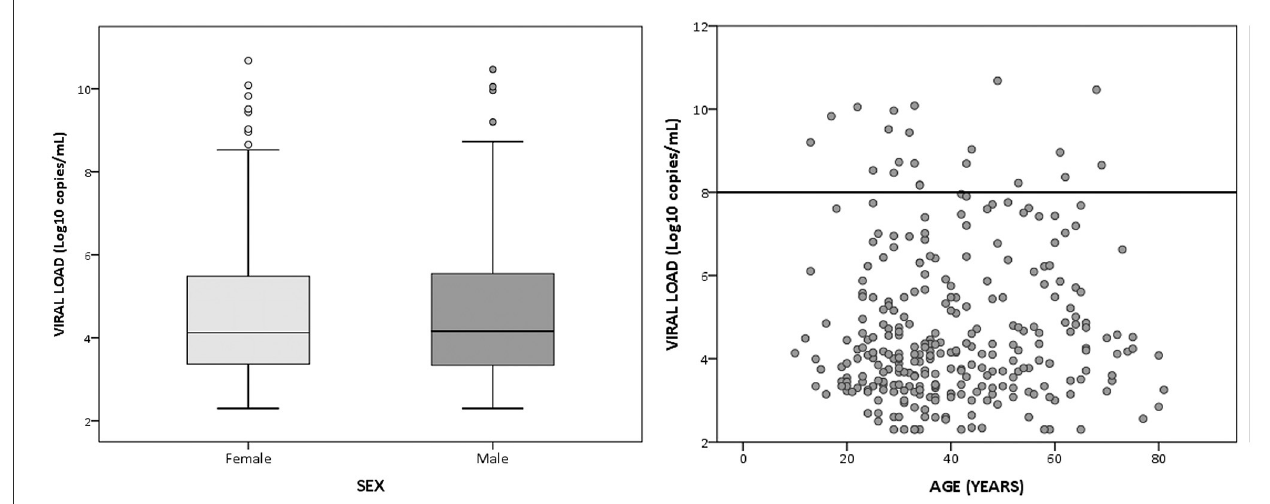
FIGURE2 Distribution of SARS-CoV-2 viral loads according to sex and age in the study population. Viral load is represented in a log